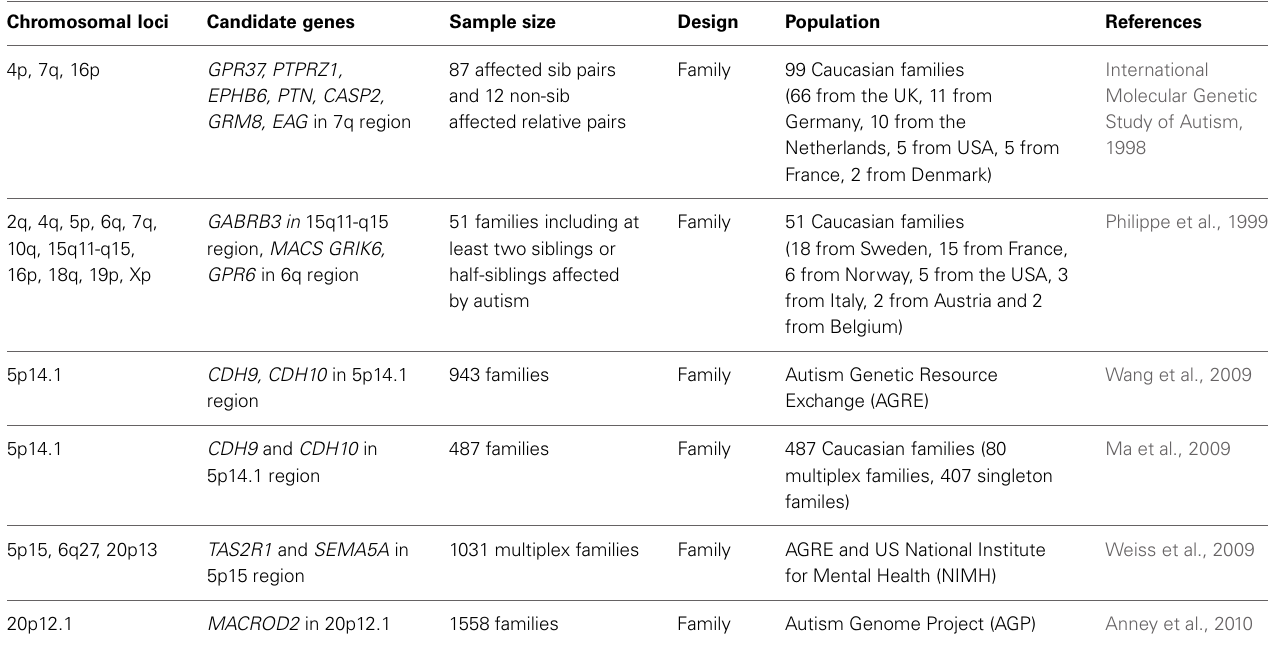
Table 1 | Examples of ASD-associated chromosomal loci and candidate genes from GWAS. Chromosomal